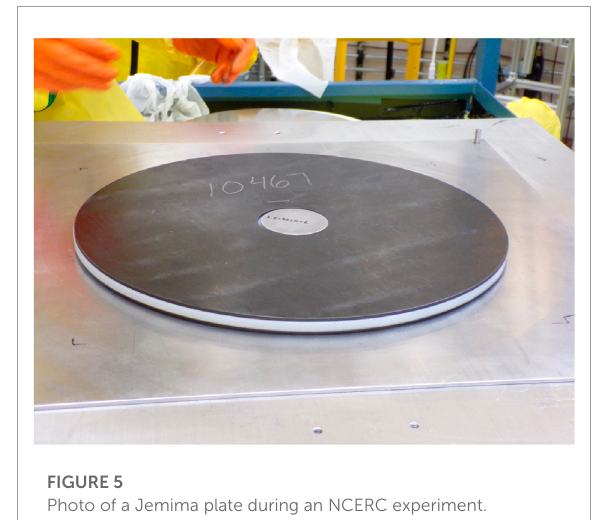
FIGURE 5 Photo of a Jemima plate during an NCERC experiment.